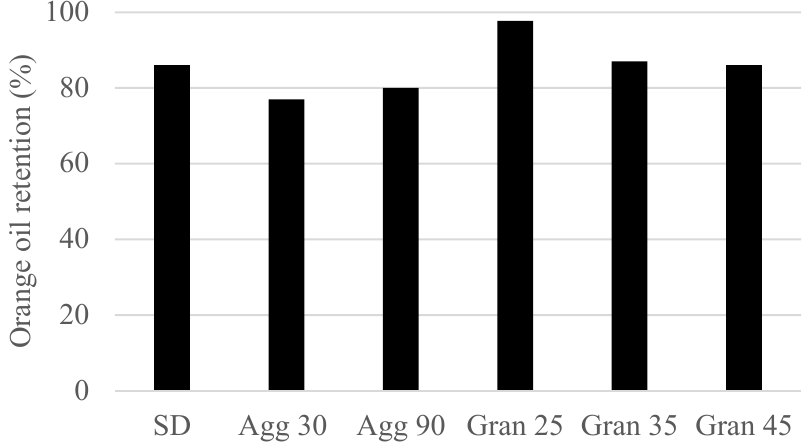
Figure 5. Influence of process (SD—spray dry; Agg xx—agglomeration min; Gran xx—granulation min) (values denote an average value of sample duplicates) on the retention of orange oil in the encapsulate.